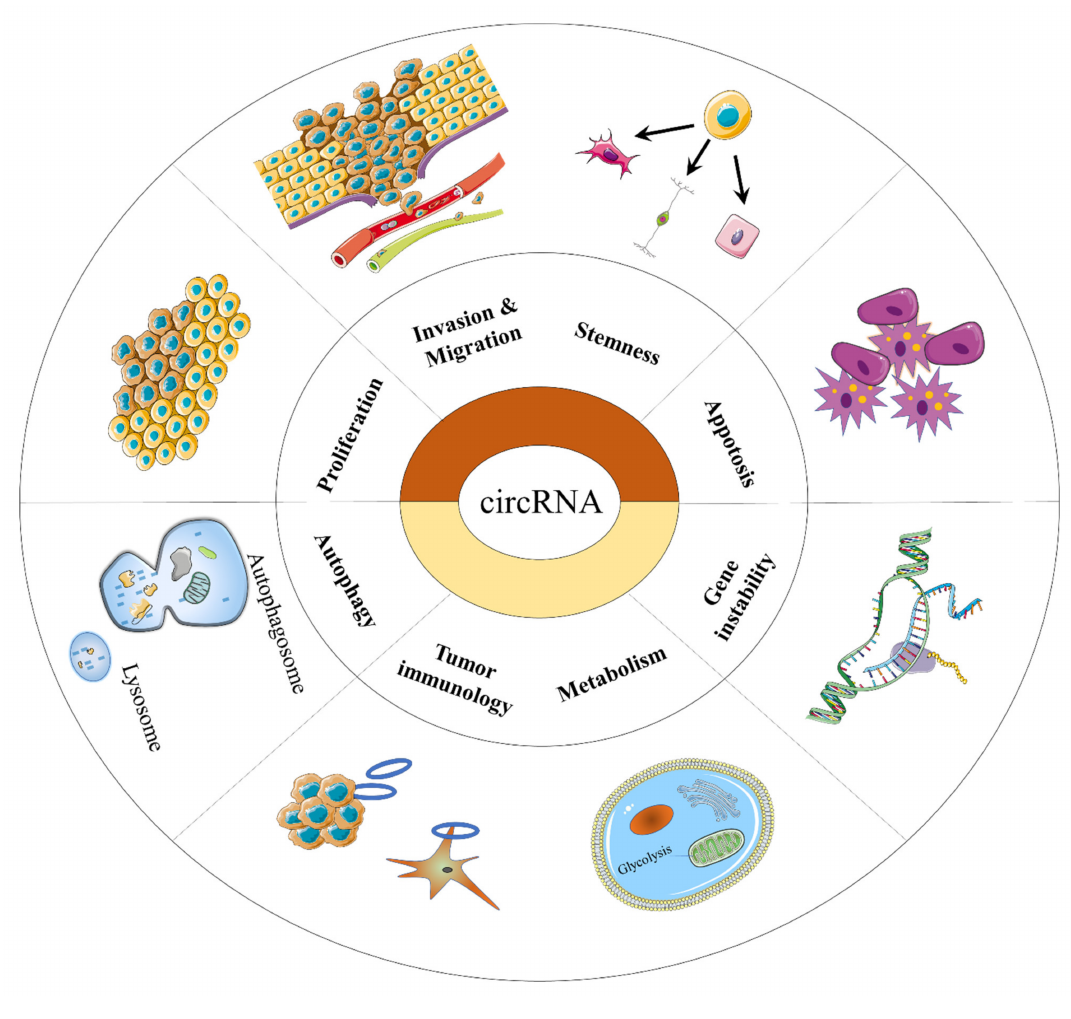
Figure 3. CircRNAs involved in the hallmarks of cancer.